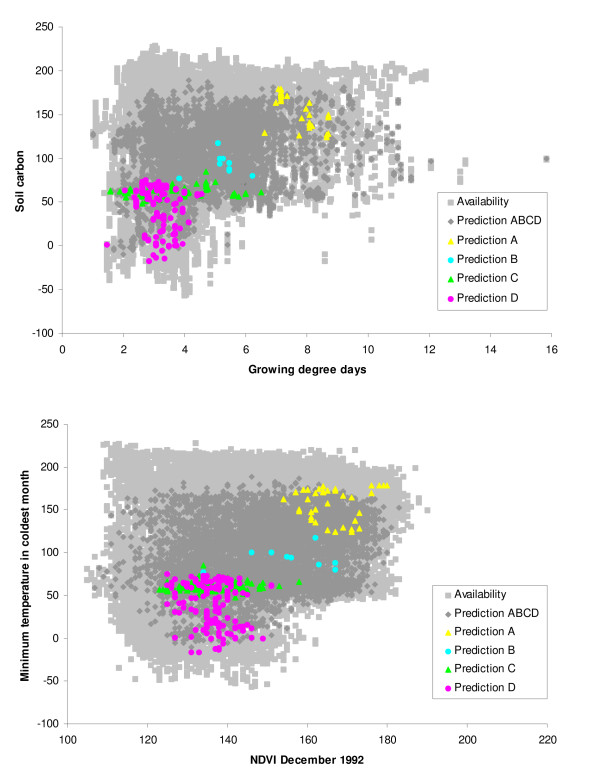
Visualizations of plague ecological niches. Examples of visualizations of modeled plague ecological niches are shown in two-dimensional spaces. Shown are all available habitat in the area of observation (light grey squares); general plague niche predicted by all available occurrence points (dark grey diamonds); niche predicted by A (yellow triangles); niche predicted by B (blue circles); niche predicted by C (green triangles); niche predicted by D (pink circles).